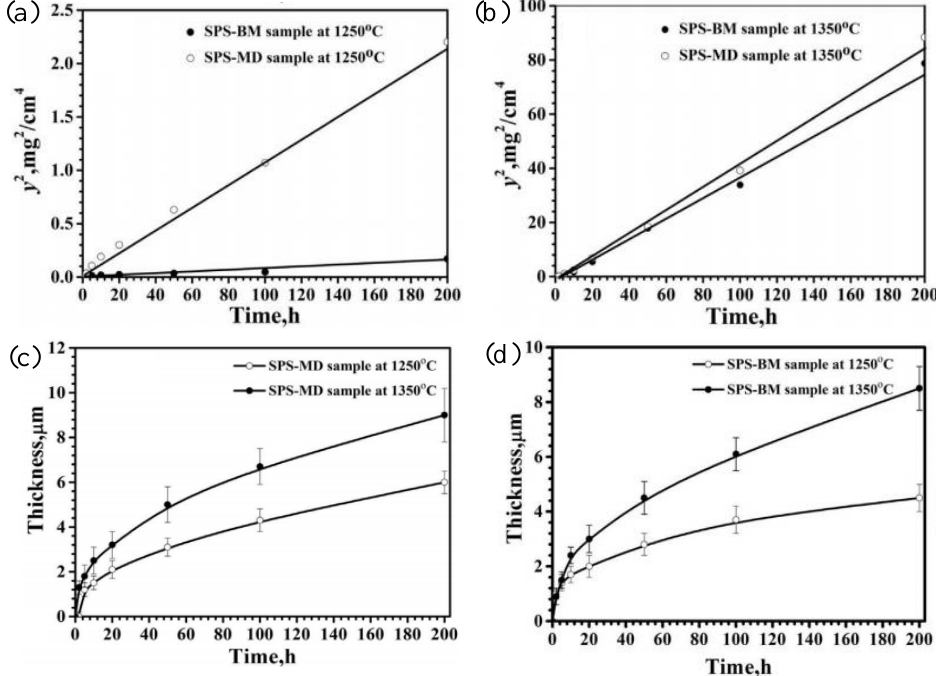
Figure 7. ( a , b ) Square of mass change (y 2 ) plots at different temperatures; ( c , d ) Oxide layer thickness change curve at different temperatures. Reproduced with permission [50]. Copyright 2017 Elsevier.